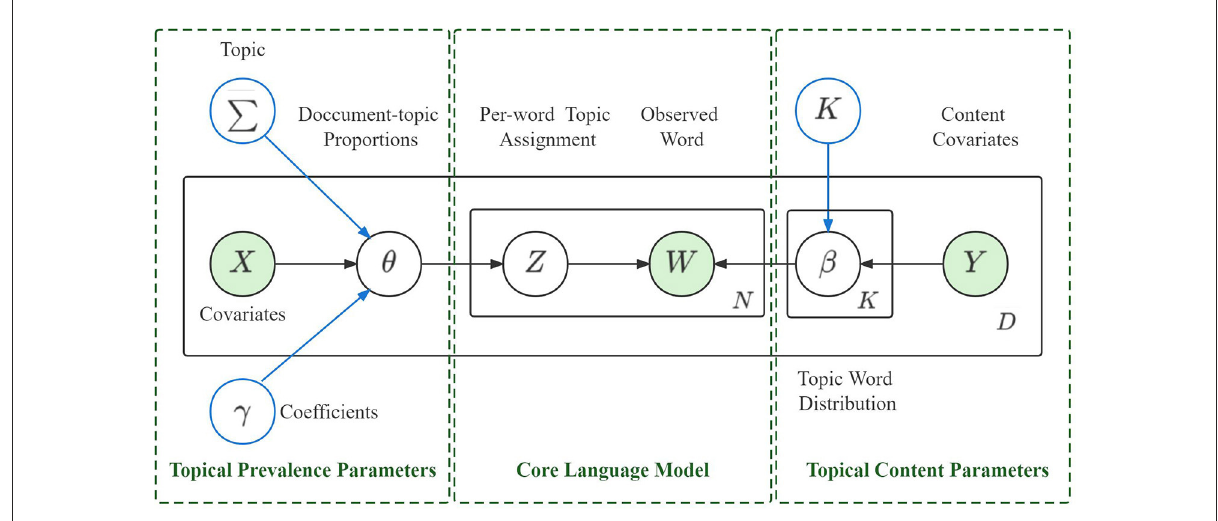
FIGURE2 Plate diagram of structural topic model